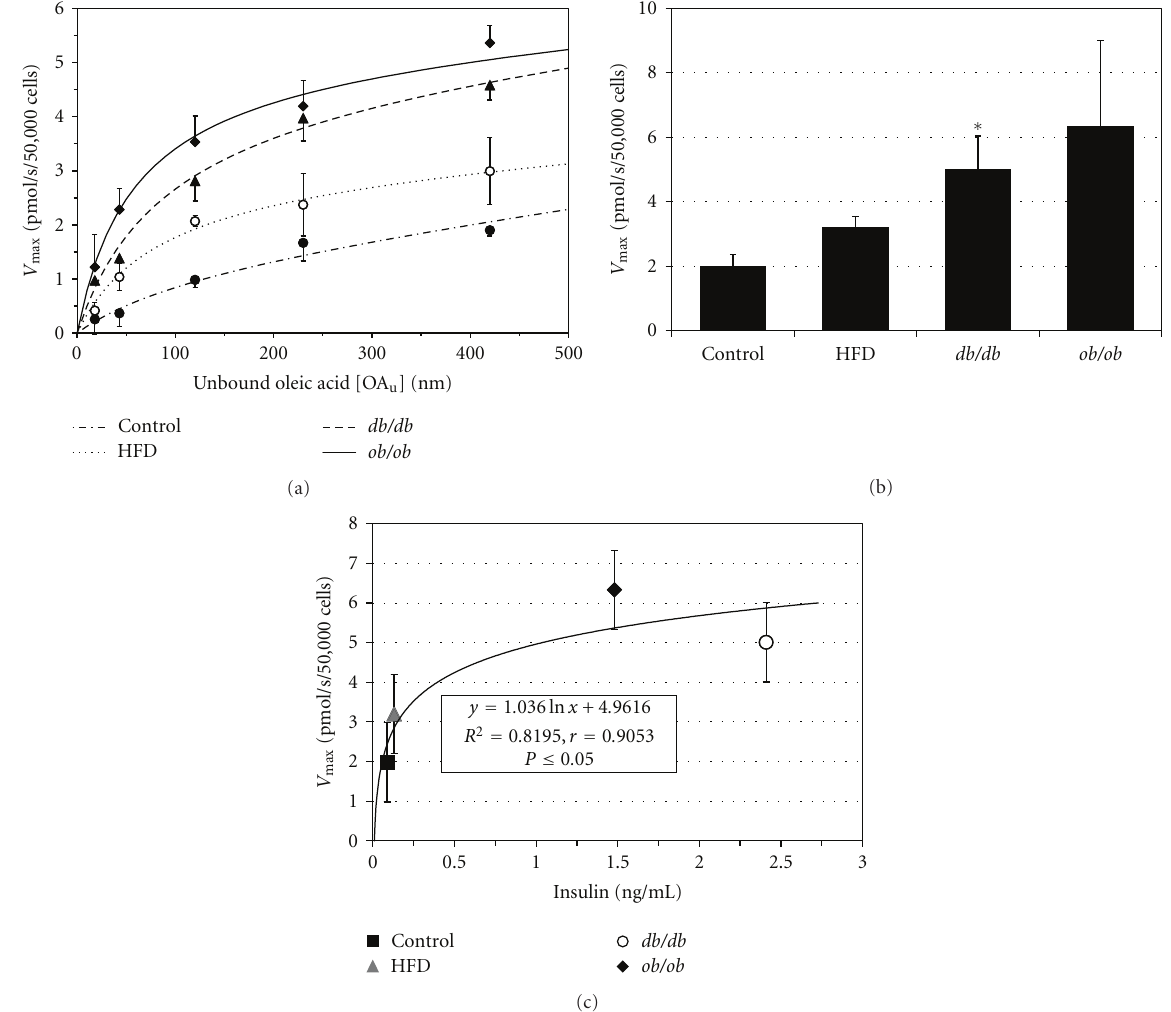
Figure 4: (a) [ 3 H]-oleic acid uptake curves for cardiomyocytes from control, HFD, db/db, and ob/ob mice. Data points are mean ± SE. (b) V max for saturable cardiomyocyte LCFA uptake is increased in all obesity groups compared with the control group. Bars represent mean 1 SE. ∗ indicates P < 0 . 05 compared to controls. (c) Relationship between serum insulin concentration and [ 3 H]-oleic acid uptake V max , indicating a significant nonlinear correlation which may reflect, in part, insulin